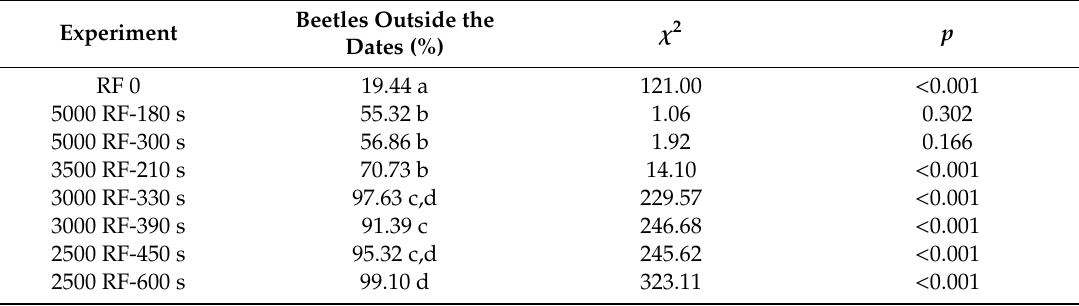
Table 4. Comparison between the Carpophilus hemipterus adults that emigrated outside the dates and those remaining inside in each experiment (di ff erence to 100) (Goodness of fit, Chi-square test 1:1) and comparisons among percentages (Marascuilo test) of C. hemipterus adults that moved outside the dates in all the experiments (percentages calculated on the overall number of insects in each experiment). Numbers of C. hemipterus include alive and thermal treatment-killed beetles.